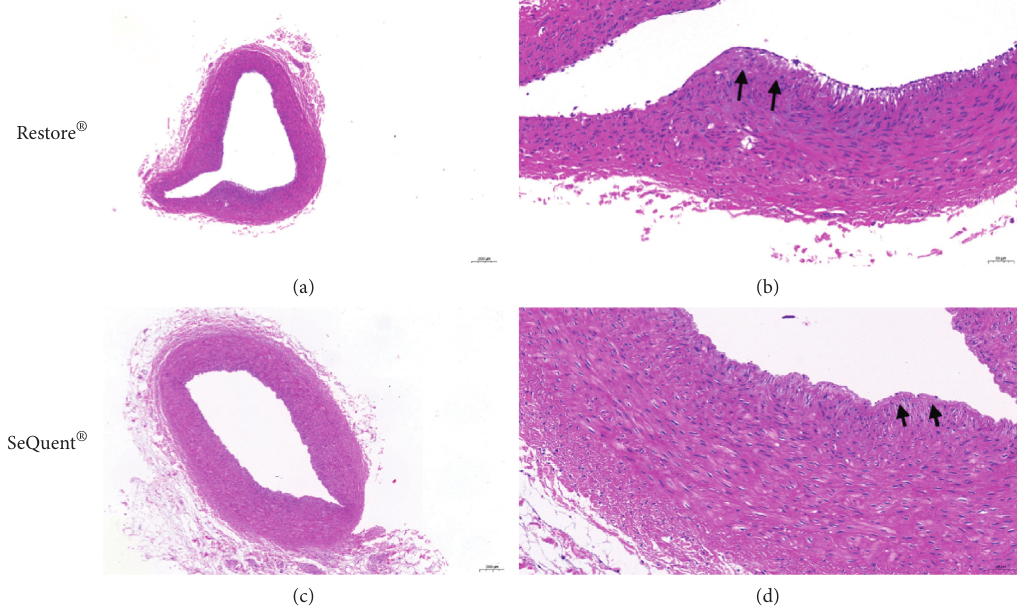
Figure 4: Representative histopathological images of coronary arteries. Cross-sectional vessel segment of an animal from Restore ® group (a, b) and SeQuent ® Please group (c, d) showing mild internal elastic lamina lacerated (black arrow). Scale bars are 200 μ m (a, c) and 50 μ m (b, d).